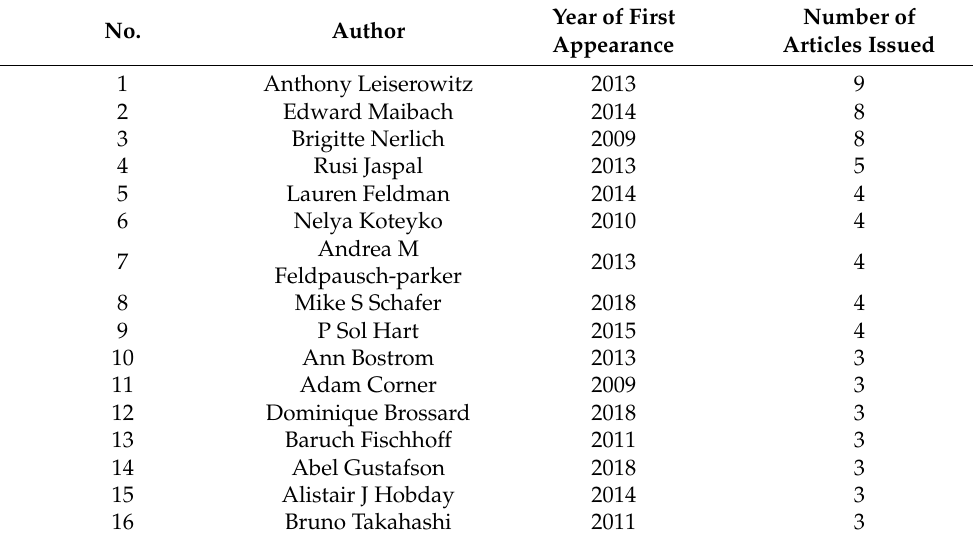
Table 2. The most prolific authors in the field of climate communication science research.